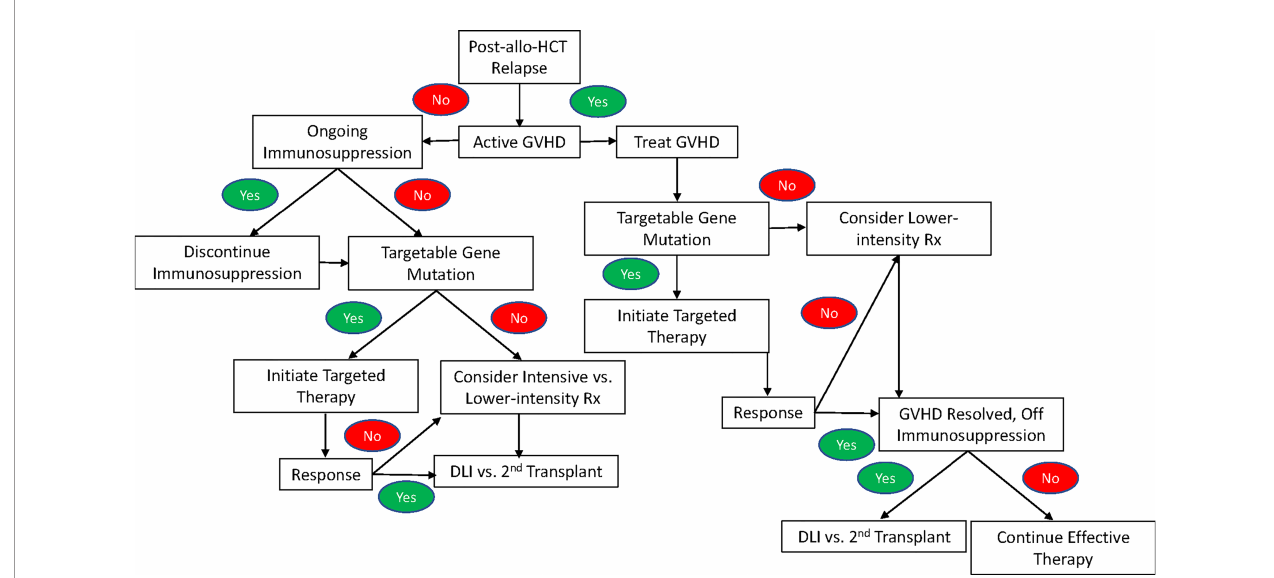
FIGURE 1 | An algorithm for the treatment of relapse of AML after allogeneic hematopoietic stem cell transplant following a standard-of-care approach in the absence of an available clinical